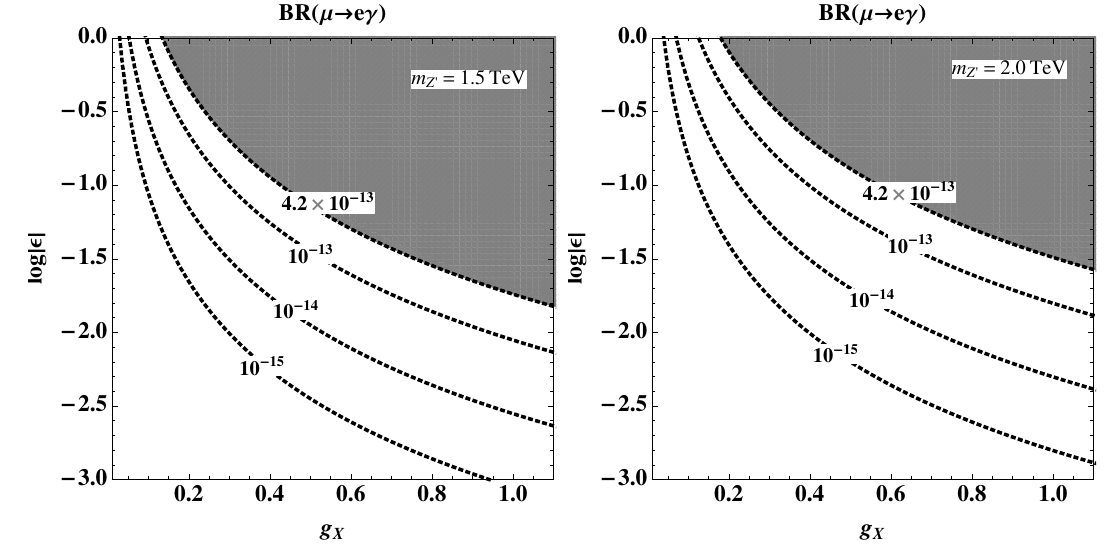
Figure 3 . BR ( (cid:22) ! e(cid:13) ) as a function of f g X ; log j (cid:15) jg (cid:12)xing m Z 0 = 1 : 5(2 : 0) TeV for left(right) plot where the shaded regions are excluded.